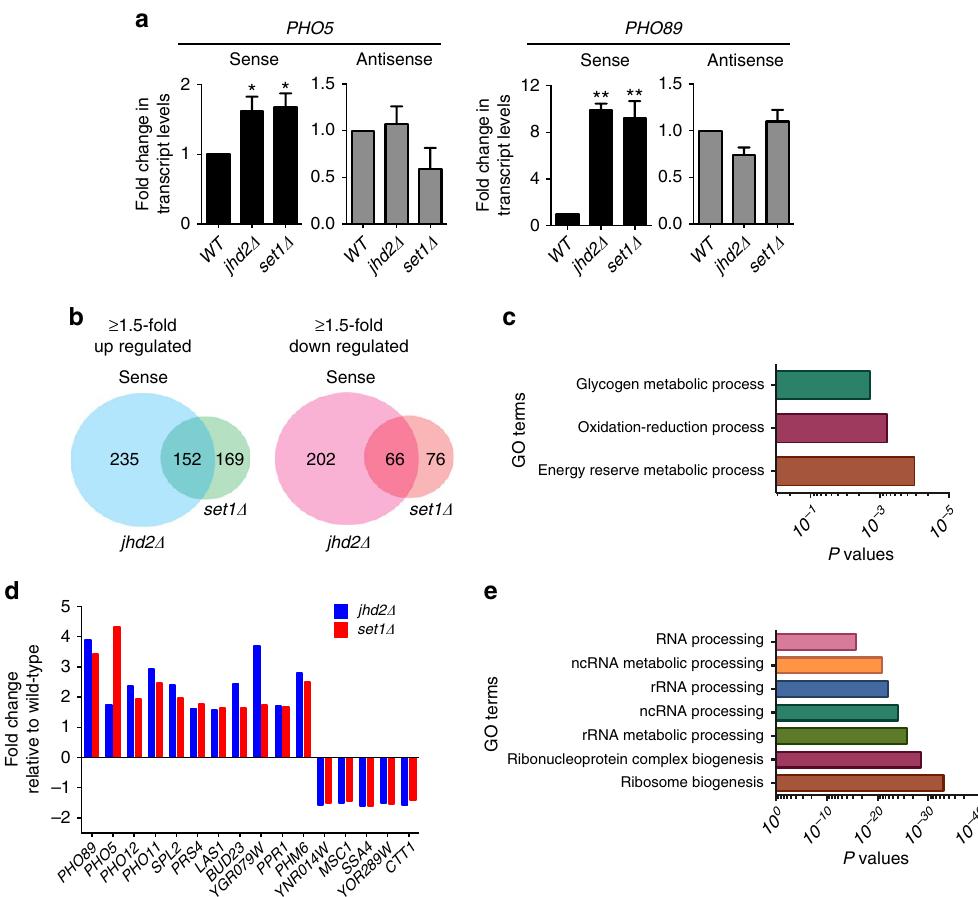
Figure 1 | Counteracting enzymes Set1 and Jhd2 function to positively or negatively co-regulate transcription in yeast. ( a ) Strand-specific qPCR measurement of PHO5 or PHO89 sense and antisense transcription. Fold-change in transcript levels in a mutant is shown relative to WT strain (WT) (set as 1). Error bars denote ± s.e.m. from three independent experiments ( n ¼ 3). Statistical significance calculated using the Student’s t -test, * P- value r 0.02, ** P- value o 0.001. ( b ) Venn diagrams showing the number of up- or down regulated sense transcripts unique to and common to jhd2 D and set1 D mutants. Intersection P- value o 10 (cid:2) 4 (hypergeometric test). ( c ) GO terms enriched in sense transcripts down regulated in both set1 D and jhd2 D mutants. ( d ) Set1 and Jhd2 either positively or negatively regulate transcription at the phosphate-responsive genes. Fold-change in total RNA-seq reads obtained in jhd2 D or set1 D mutant relative to WT for various phosphate-responsive genes are shown. ( e ) GO terms enriched in sense transcripts up regulated in both set1 D and jhd2 D mutants.